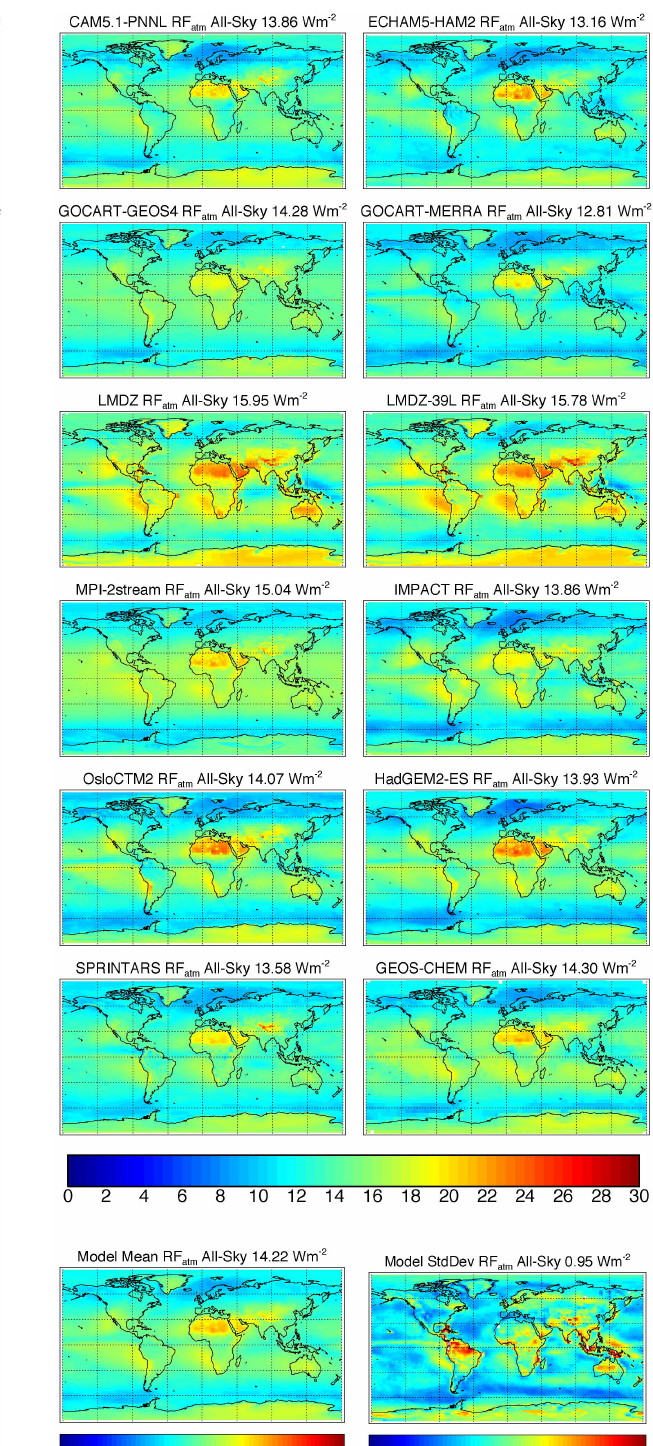
Fig. 11. Annual mean short-wave all-sky atmospheric radiative forcing (absorption) between experiments with AOD=0.2 and AOD=0.0 distributed over the lowest two kilometers, holding SSA=0.8 and ANG=1.0 constant